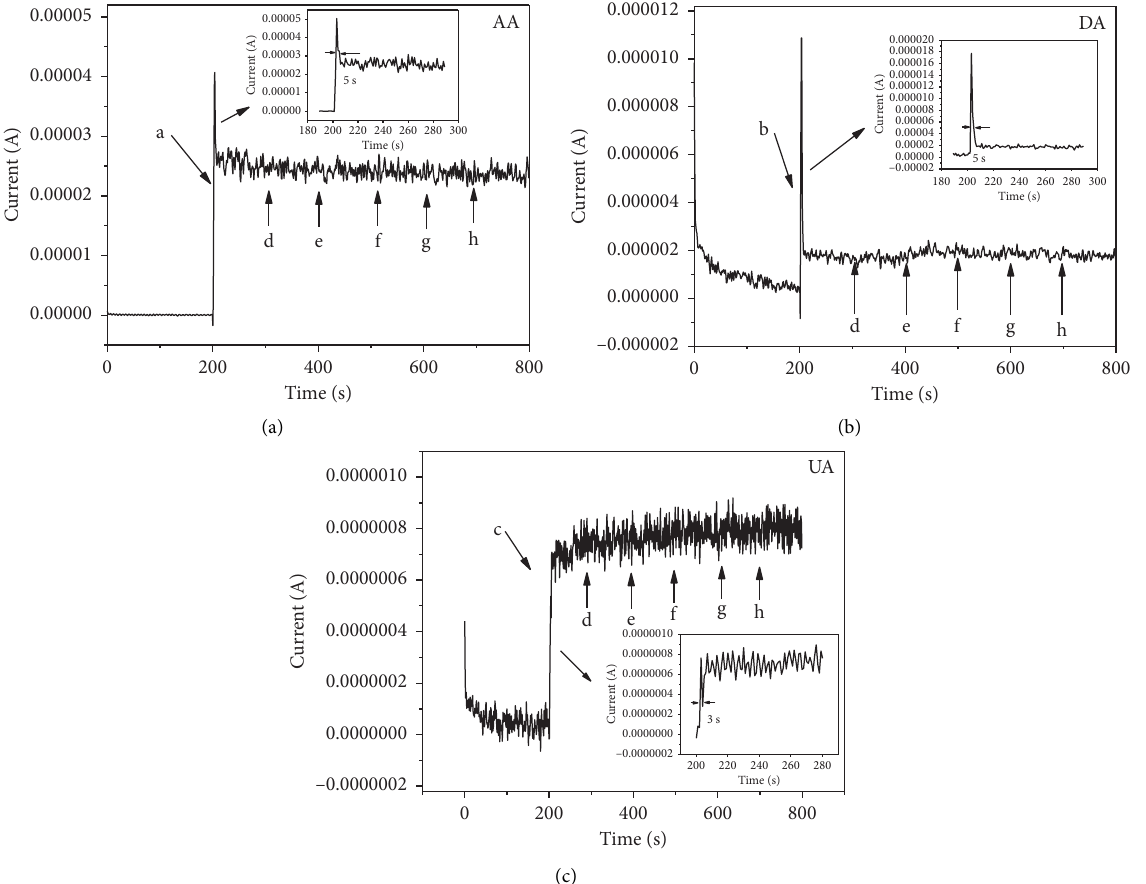
Figure 8: Amperometric responses of 1mM AA (a), 50 μ M DA (b), and 0.1mM UA (c) in the presence of 100-fold concentration of